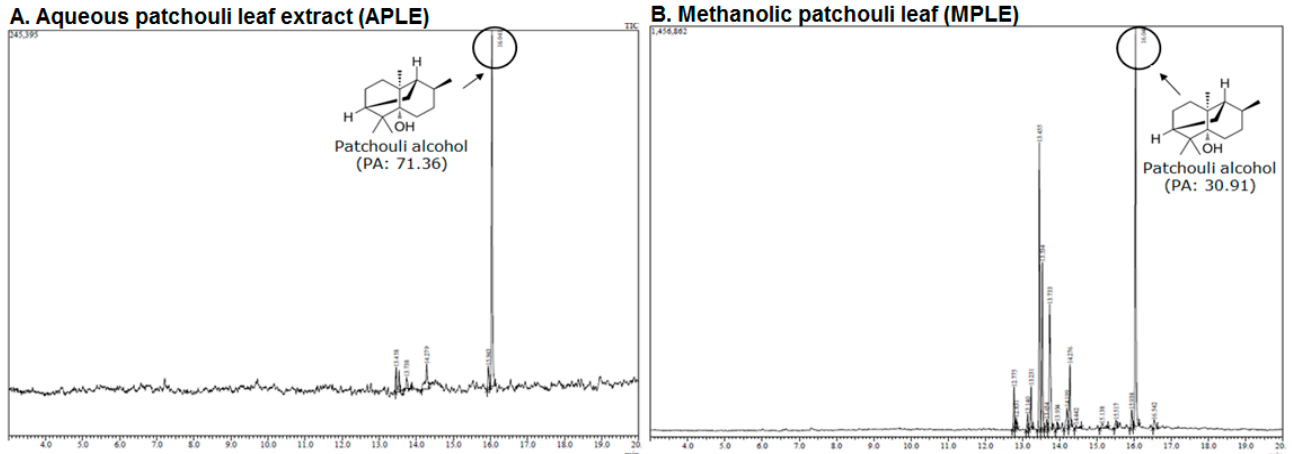
Figure 3. The GC-MS spectrum; ( A ) aqueous patchouli leaves extract (APLE), and ( B ) methanolic patchouli leaves extract (MPLE).